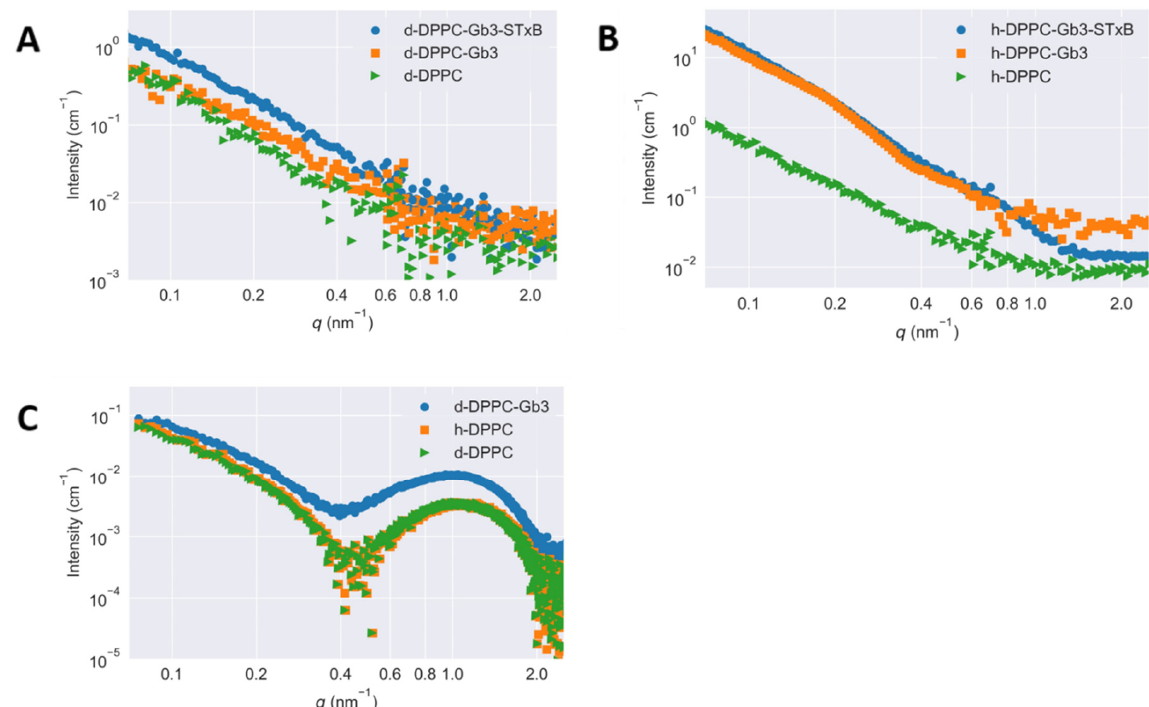
Figure 2. Small-angle scattering curves of the SUV samples of Gb3 and DPPC mixture ([Gb3]/[DPPC] = 0.1/1. Measurements were performed at T = 25 ◦ C. ( A ) Small-angle neutron scattering curves of [h-DPPC]/[d-DPPC] = 1/0; ( B ) small-angle neutron scattering curves of [h-DPPC]/[d-DPPC] = 0/1; ( C ) small-angle X-ray scattering curves for fully protiated and deuterated DPPC, and fully deuterated DPPC with Gb3. Table 1. The scattering length density used to determine contrast distribution profiles of the SUV bilayer structures for neutron scattering (×10 − 11 cm − 2 ). The SUV samples of Gb3 and DPPC mixture was prepared with [Gb3]/[DPPC] = 0.1/1. The SLD of hydrophilic head portions of h-DPPC and d-DPPC were identical, the high contrast comes from the hydrophobic tail portions of DPPC molecules.